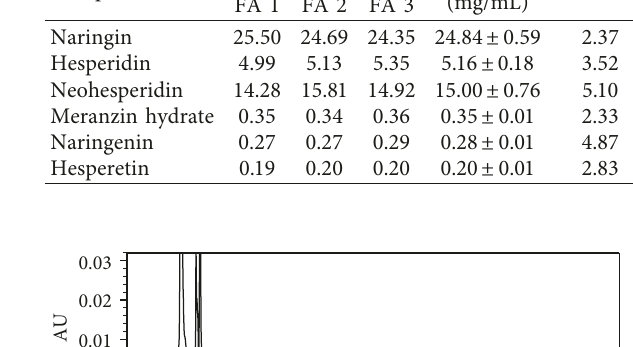
Table 1: Contents of six components in FA decoction (1.7g/mL; n � 3). Components